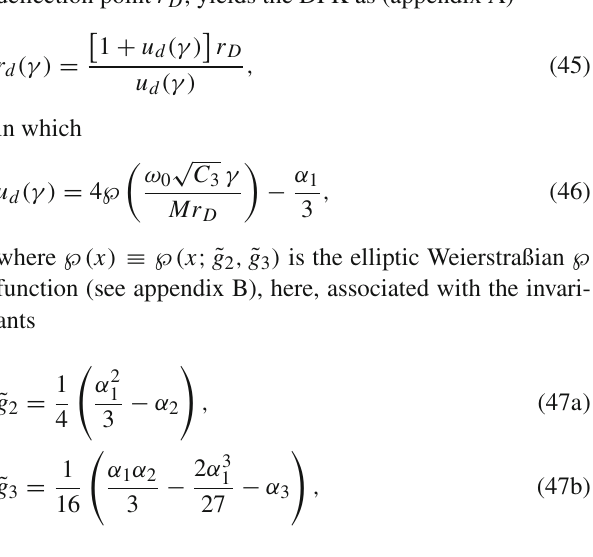
The turning points r D and r F correspond to different fates